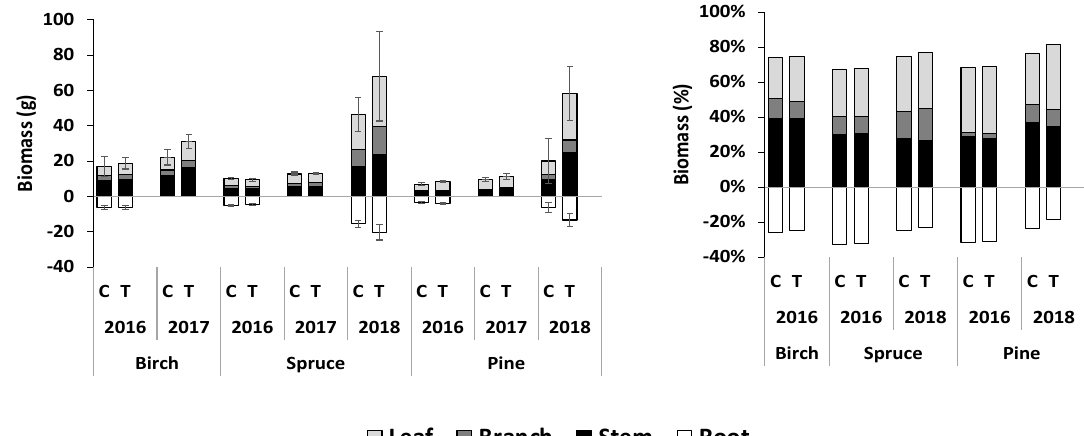
Figure 3. Biomass and its percentage allocation in silver birch, Norway spruce and Scots pine seedlings harvested in different years (2016, 2017 and 2018) under warming treatment (T) and ambient (C) conditions. The x -axes contain the years of harvest. Error bars describe the ±SD of shoot biomass and root biomass.